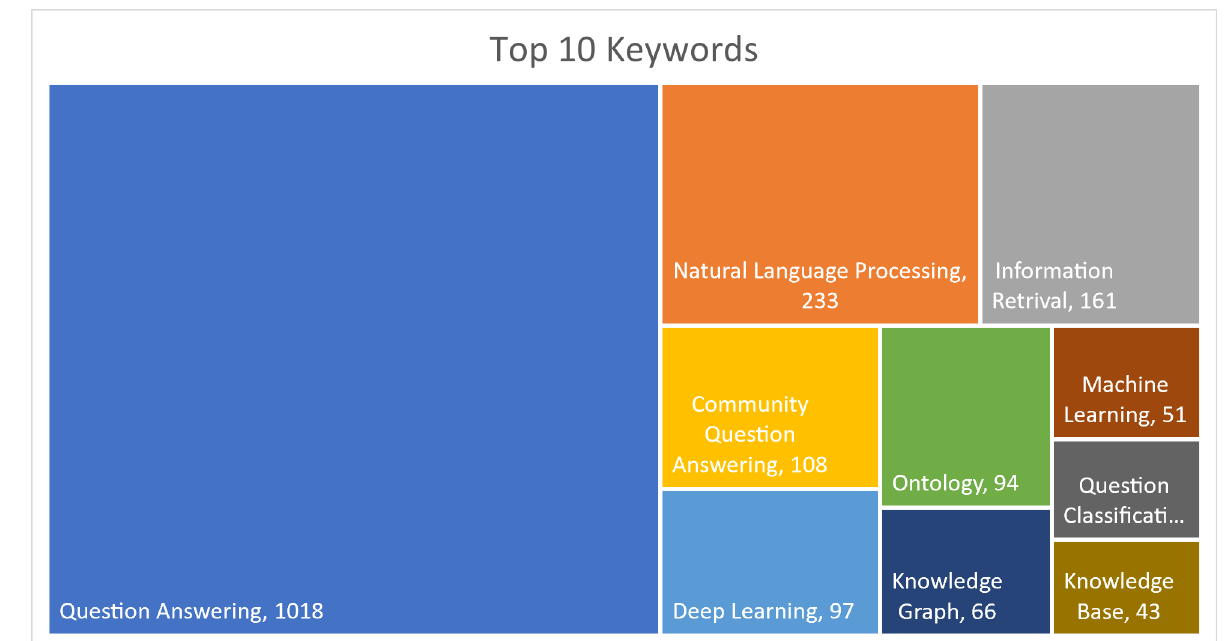
Figure 14. As expected, Question-answering and Natural Language Processing are the two